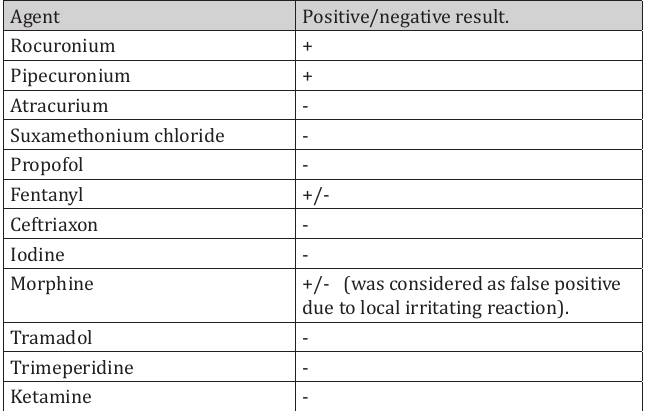
Figure 1 - Skin prick tests